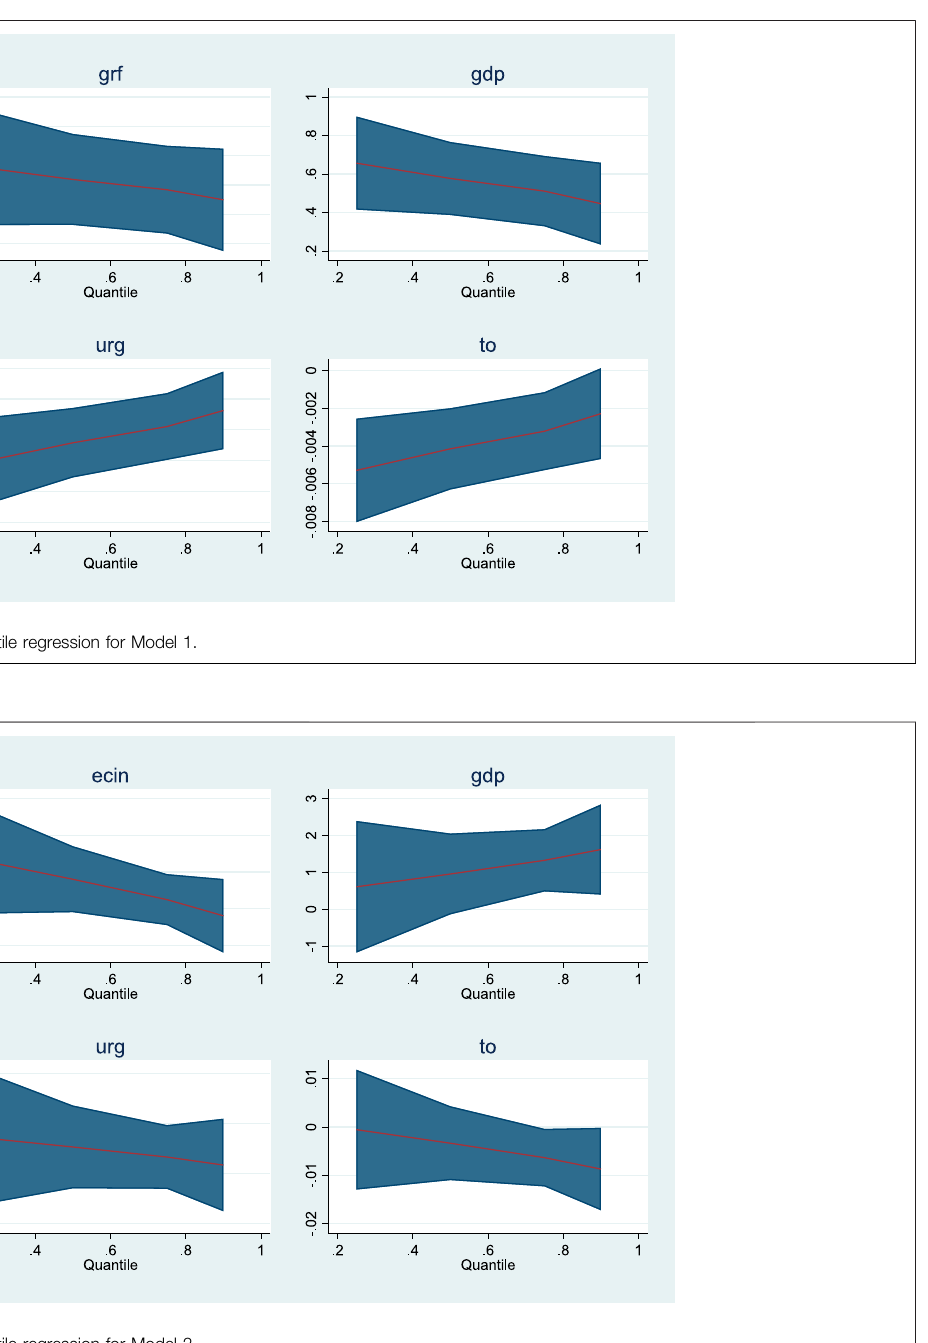
FIGURE 3 | Graphical presentation of quantile regression for Model